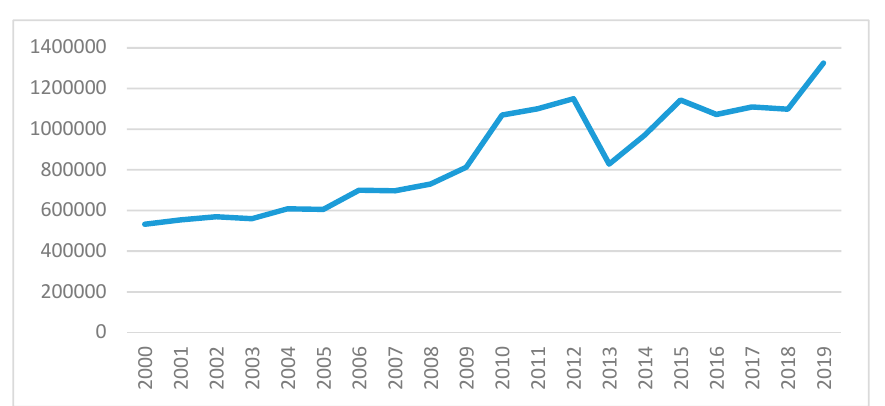
Figure 1. Total generation of organic waste (thousand tones) [91,92].